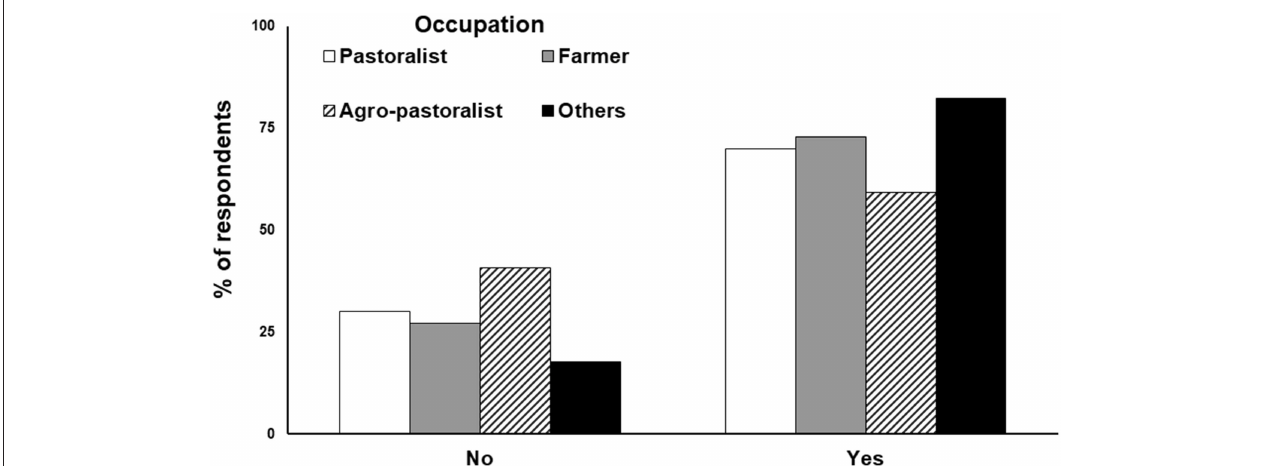
FIGURE 5 | Attitudes of local people ( n = 680 respondents) from 254 villages in the landscape outside the Gir PA regarding the continued presence of lions in their neighborhood. The respondents were categorized based on their livelihoods. The category “others” primarily represent individuals associated with the tourism industry like hoteliers, safari-vehicle providers,